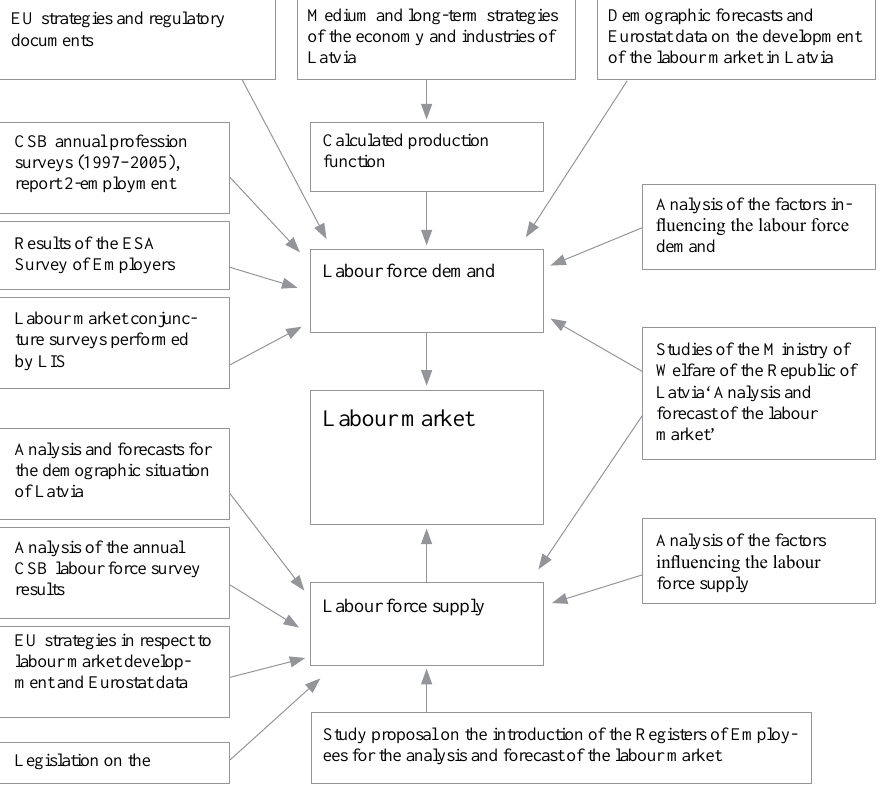
Fig. 1. Scheme of information flows of the labour force demand and supply research